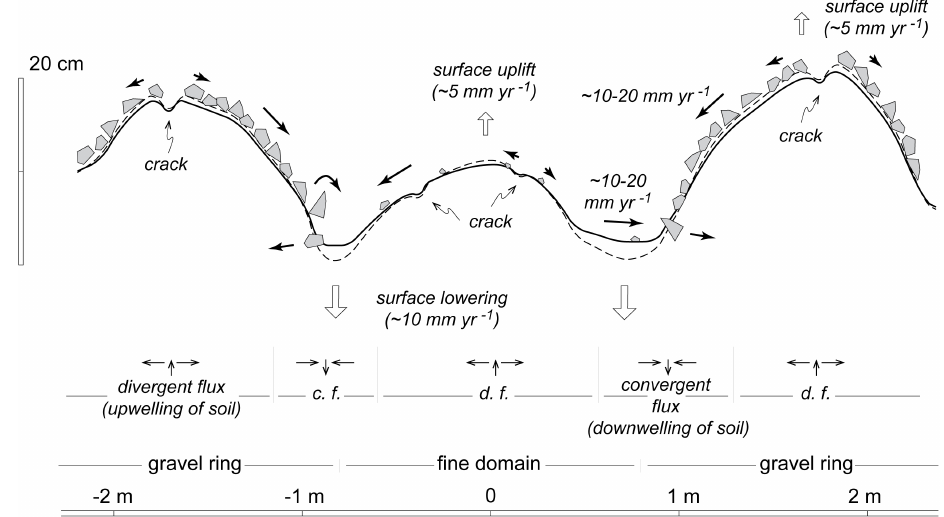
Figure 3. Generalized surface cross section and findings regarding changes over 2007–2010 on the stone circles of this study. The topographic profile shown is approximately a southwest–northeast cross section over the centre of the middle circle. The solid line indicates the year 2007, and the dashed line 2010. Black arrows indicate soil surface movement, and the white vertical arrows surface elevation changes. Vertical exaggeration is